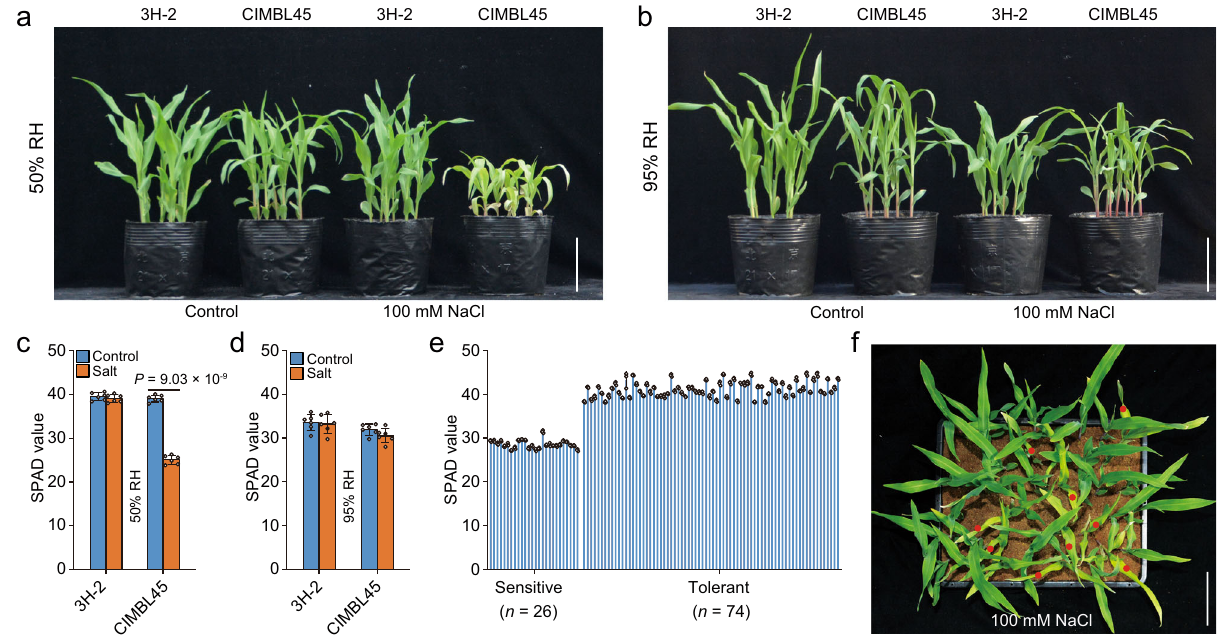
Fig. 1 CIMBL45 shows a transpiration-dependent salt hypersensitive phenotype. a – d The appearances ( a , b ) and SPAD values ( c , d ) of plants grown under control and salt (100 mM NaCl) conditions with indicated relative humidity (RH) (genotypes as indicated). e , f The SPAD values ( e ) and appearances ( f ) of the F2 plants grown under salt condition with 50% relative humidity. The results in ( c ) and ( d ) were means ± s.d. of three independent experiments. The SPAD values in e were expressed as means ± s.d. of three measurements. Statistical signi fi cance was determined by a two-sided t -test. Bars in ( a ), ( b ), and ( f ), 10 cm. Source data are provided as a Source Data fi